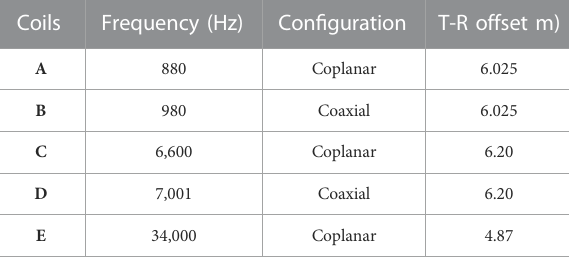
TABLE 1 Parameters of AEM system (Rønning et al.,